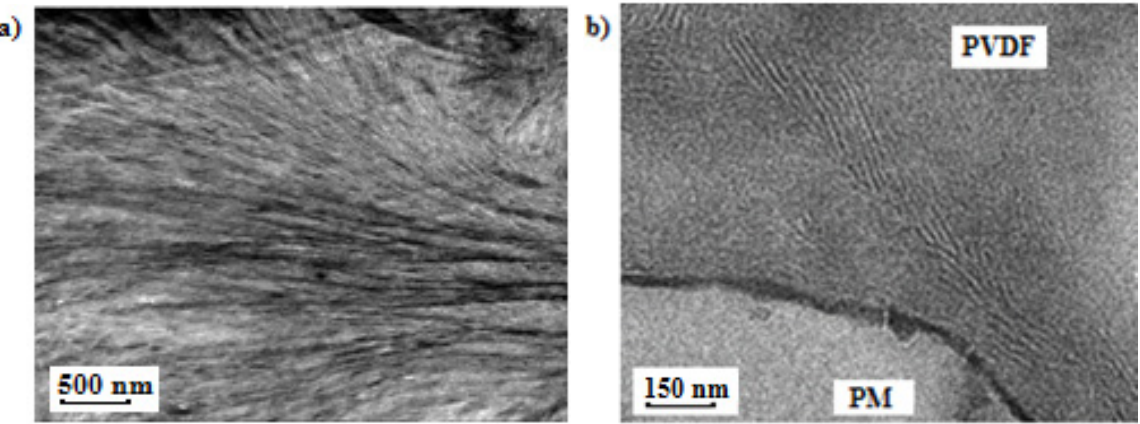
Figure 3. TEM images for ( a ) PM 23 - b -PVDF 77 linear diblock copolymer and ( b ) PM 23 PVDF 77 blend after cooling the samples at 20 °C/min to 25 °C.